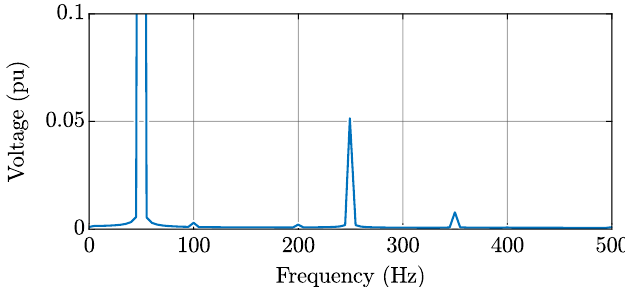
Figure 20. Simulated harmonic compensation test for D-STATCOM. A 5% 5-th harmonic component is introduced into the emulated grid and the STATCOM does not